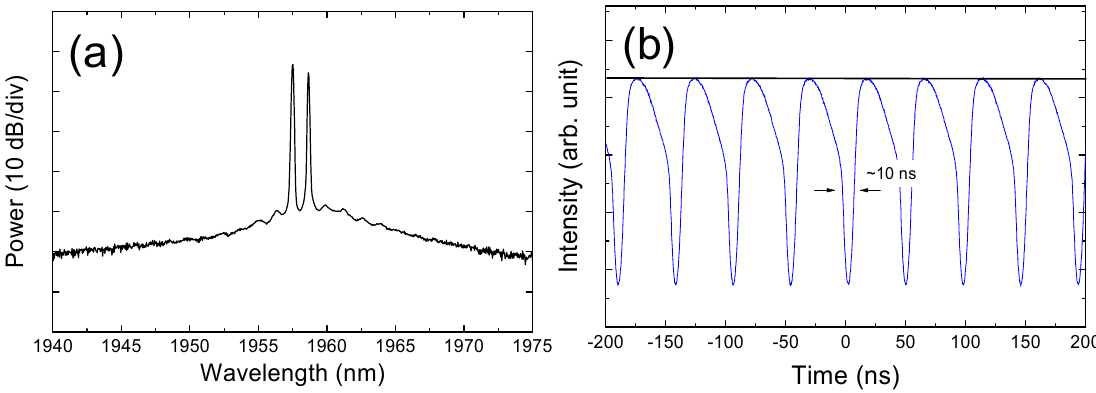
Figure 6. Measured ( a ) optical spectrum and ( b ) oscilloscope traces of the dark pulses.